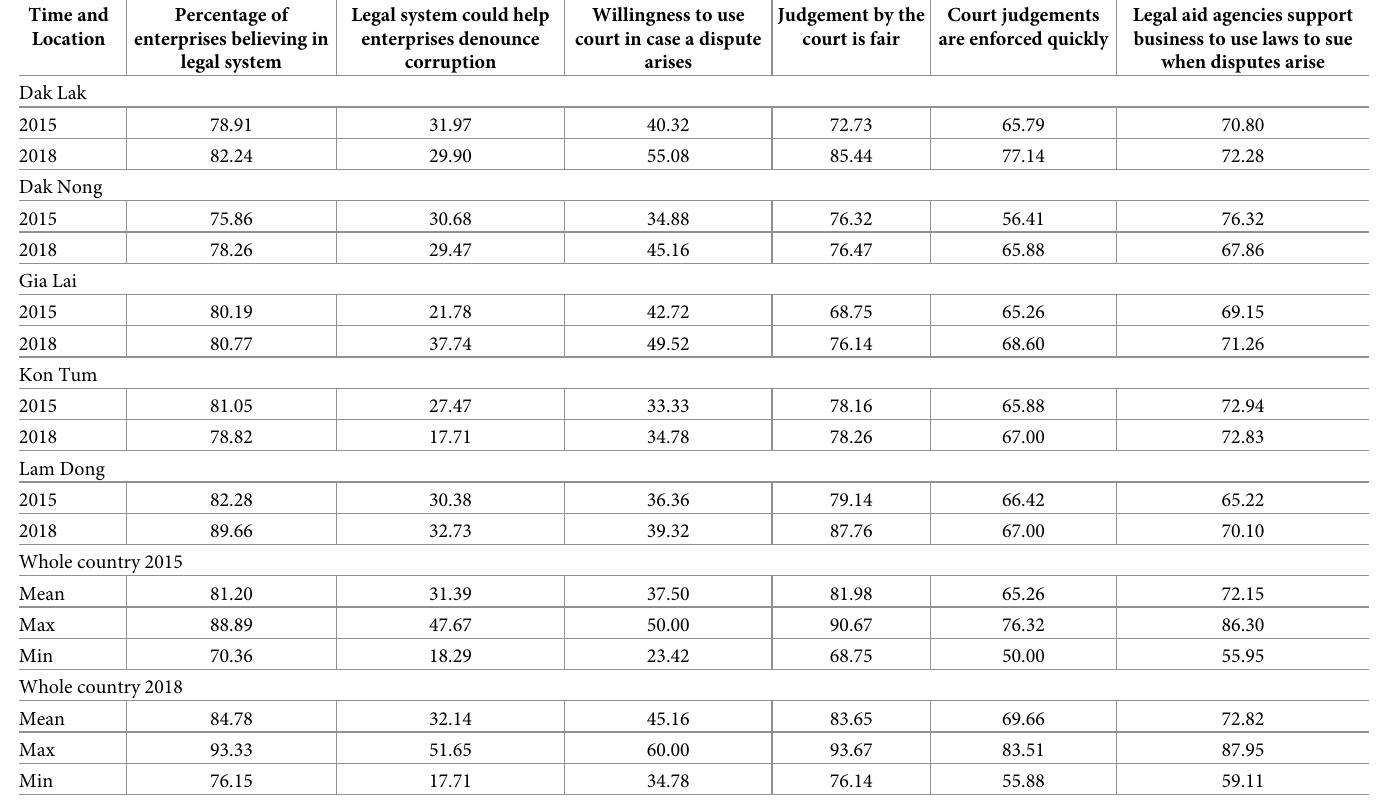
Table 4. Indicators in “legal institutions” sub-index in the Central Highlands. Unit: %. Time and Percentage of Location enterprises believing in legal